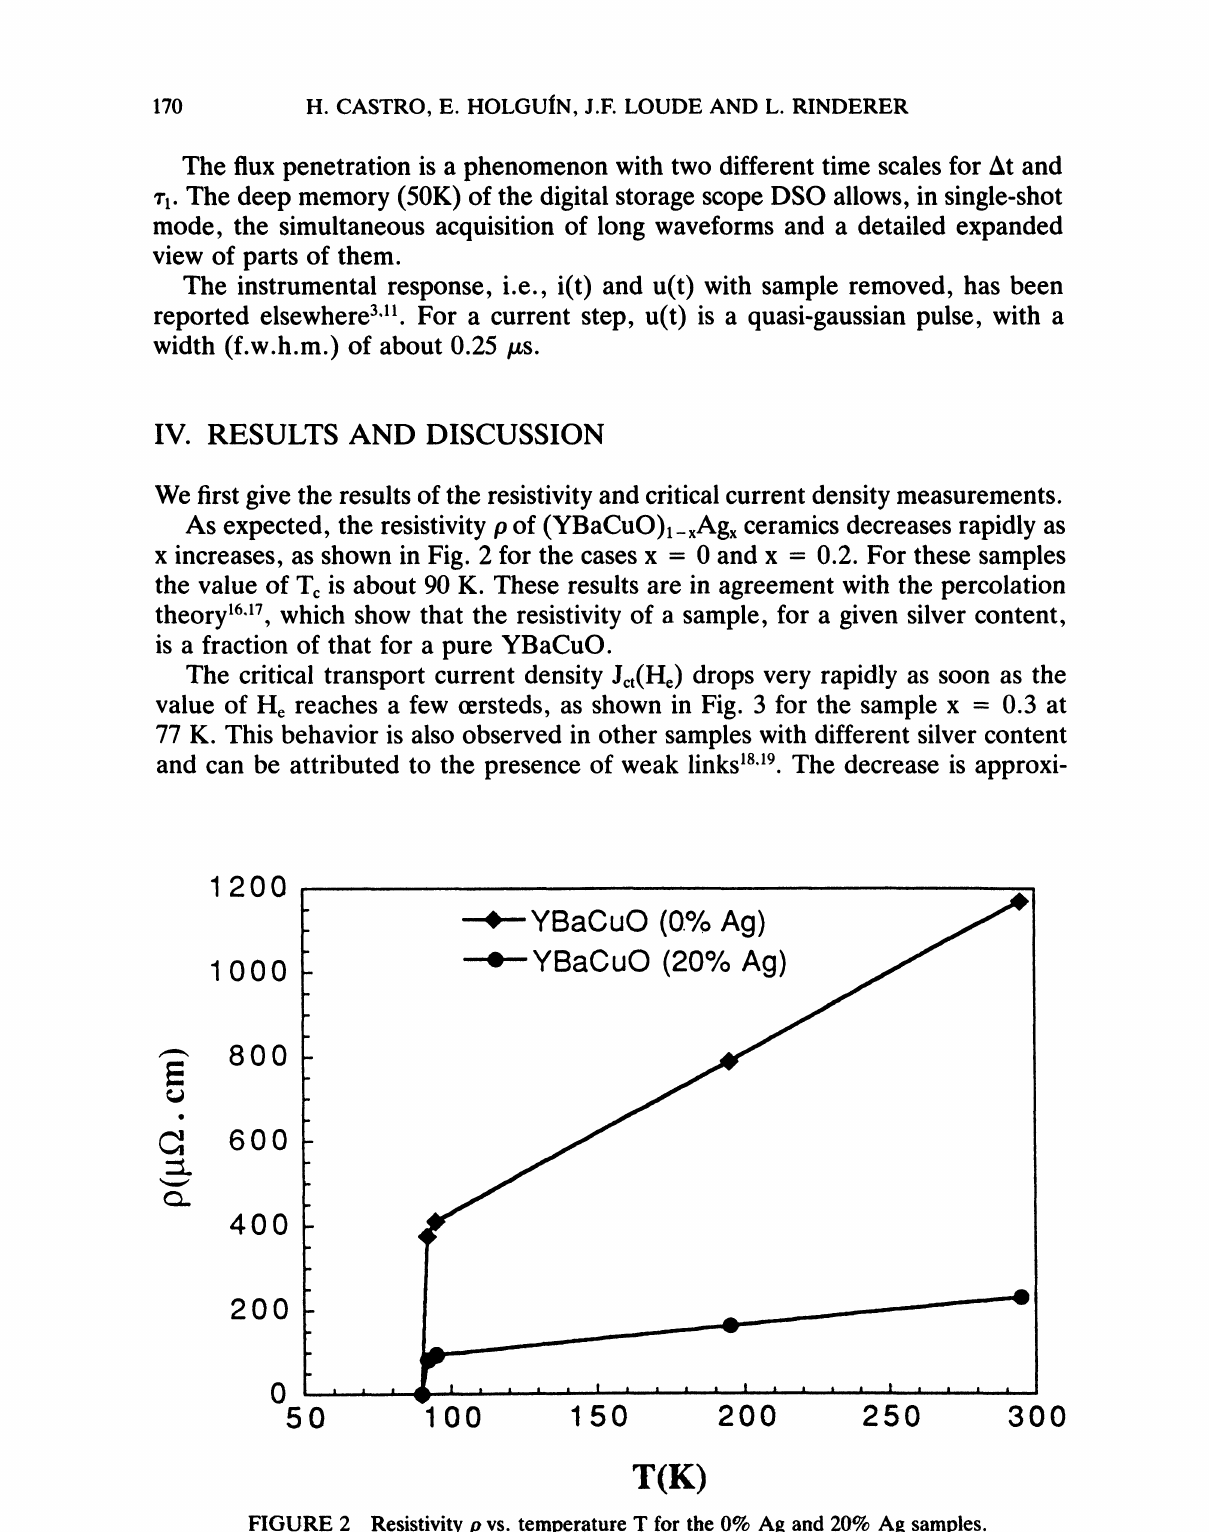
FIGURE 2 Resistivity p vs. temperature T for the 0% Ag and 20% Ag